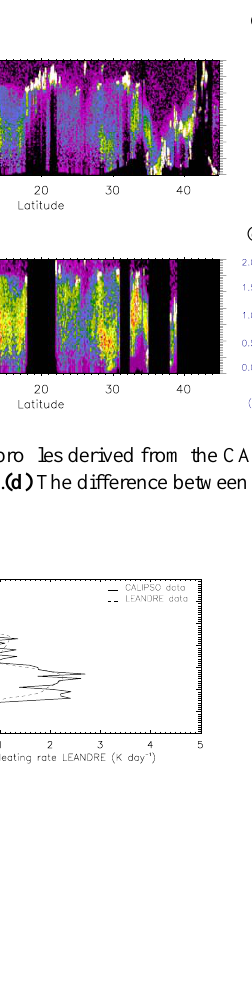
Fig.14. Comparisonof (a) AECand (b) heatingrateprofileswithRaCHmodelon14Juneat12 ◦ NderivedfromLEANDRE2(solidline) andfromCALIOP(dashline). (c) Scatterplotoftheprofile-to-profilecomparisonofheatingratesobtainedwithLEANDRE2andCALIOP between5 ◦ and15 ◦ N.Thelinearregressiontroughtheclusterisgivenbytheredsolidline. Fig. 14. Comparison of (a) AEC and (b) heating rate profiles with RaCH model on 14 June at 12 ◦ N derived from LEANDRE 2 (solid line) and from CALIOP (dash line). (c) Scatter plot of the profile- to-profile comparison of heating rates obtained with LEANDRE 2 and CALIOP between 5 ◦ and 15 ◦ N. The linear regression trough the cluster is given by the red solid